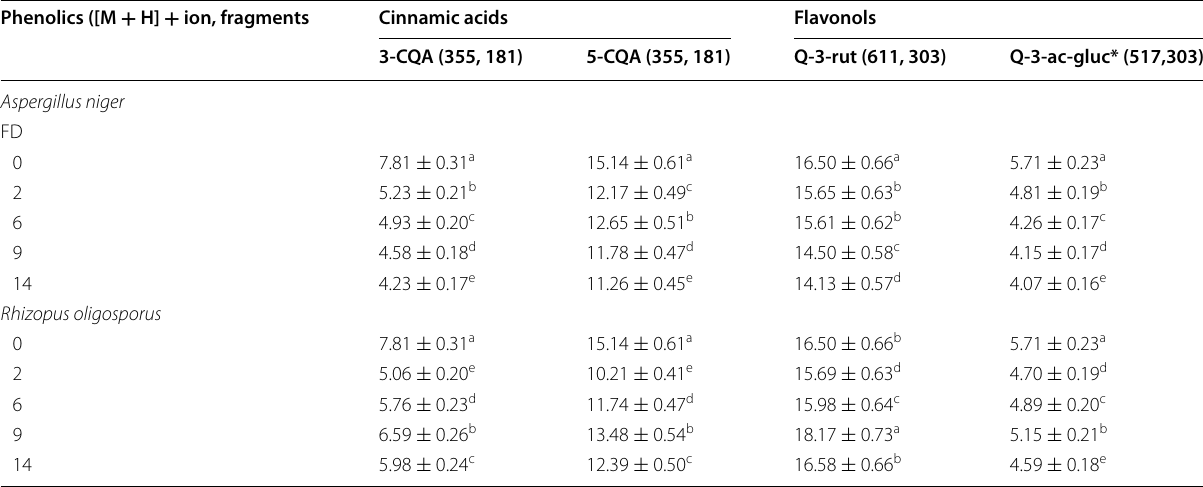
Values (mean SD, n 3) in the same column with different letters (a–e) significantly differ ( p < 0.05) (ANOVA “Tukey’s Multiple Comparison Test”). FD fermentation ± = day, 3-CQA 3-caffeoylquinic acid (neochlorogenic acid), 5-CQA 5-caffeoylquinic acid (chlorogenic acid), Q-3-rut quercetin-3-rutinoside (rutin), Q-3-ac-gluc Quercetin-